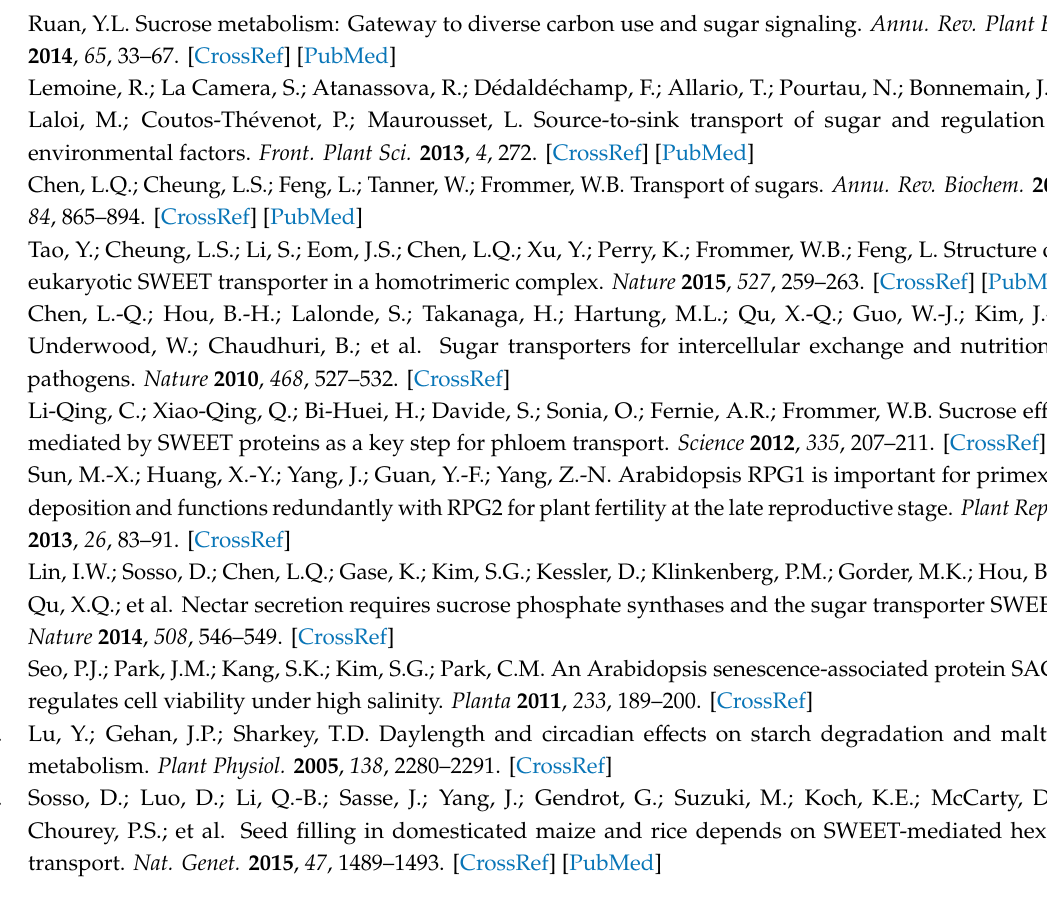
s1, Figure S1: The phylogenetic relationship and MtN3 domains of SWEET genes from di ff erent species. The phylogenetic tree was completed using the maximum likelihood method with the optimal model (JTT + G) and 1000 bootstrap replications. The exon-intron structural information feature was added by ITOL (http: // itol.embl.de), Figure S2: Multiple sequence alignment of SWEETs proteins in A. thaliana and B. rapa . The seven TM domains were assigned based on the AtSWEET1 structure indicated by Tao et al. [4]. The experimentally validated key functional sites were labeled with arrows; Table S1: Identified SWEET family genes in di ff erent plant kingdoms, Table S2: Identification and characteristics of SWEETs in A. thaliana and B. rapa , Table S3: Fractionation of SWEET homolog genes after triplication in B. rapa . The genes retained during fractionation are indicated with red 1s. The genes lost during fractionation are indicated with white 0s. The three B. rapa sub-genomes are indicated by LF, MF1, and MF2. The retained items indicate the number of B. rapa genes retained relative to those of A. thaliana within the 21-gene syntenic window, Table S4: Fragments per kilobase of the exon model per million mapped reads (FPKM) values of SWEETs in B. rapa ; Table S5: B. rapa SWEETs primers used for